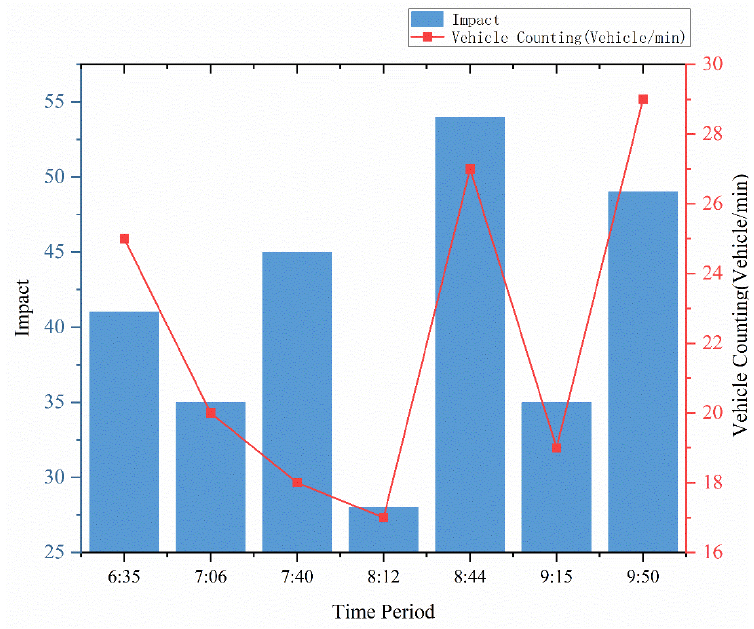
Figure 18. Noise signal impact-vehicle counting correlation diagram at position 2 of Yellow River Bridge.